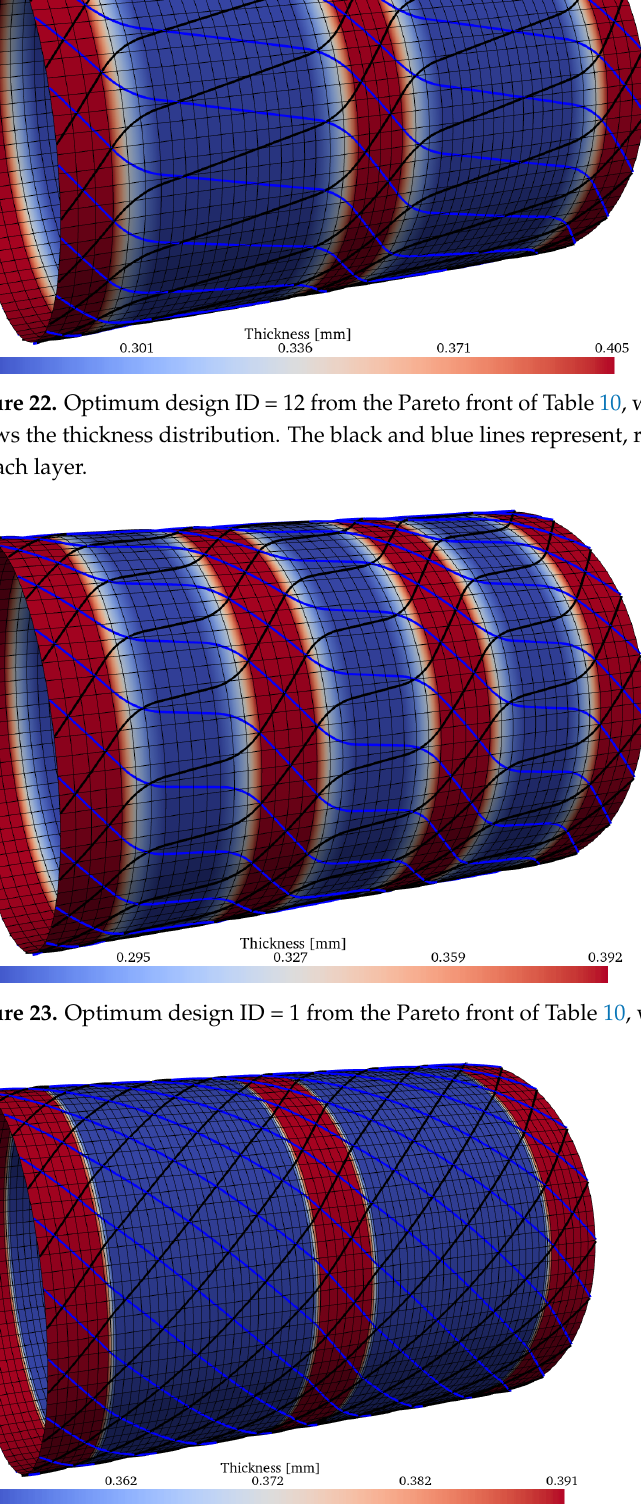
Figure 24. Optimum design ID = 13 from the Pareto front of Table 10, with m = 1.690